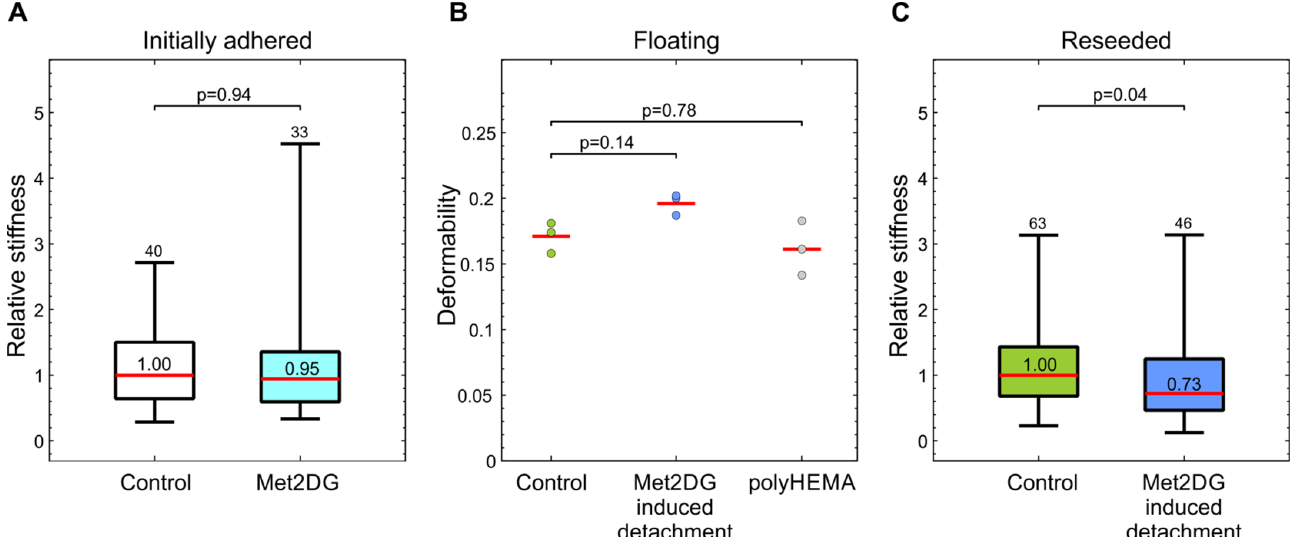
Figure 2. Mechanical properties of met2DG-treated MDA-MB-231 cells. ( A ) Stiffness of initially adhered MDA-MB-231 cells measured by optical tweezers. Met2DG treatment per se does not induce a significant cell softening ( B ) Deformability of floating MDA-MB-231 cells, detached by trypsinization (control), met2DG-treatment or cultured in polyHEMA coated flasks, as measured by deformability cytometry. The met2DG-treated cells are significantly more deformable. ( C ) Stiffness of re-seeded MDA-MB-231 cells measured by optical tweezers. Met2DG-treated cells are significantly softer than control cells. For measurements by optical tweezers, the cell stiffness is given relative to the control. The red horizontal lines represent the medians, boxes span over 50% of the data points, and the whiskers span over the total data range. The median value is indicated in the box, the number of measured cells indicated at the top and the p -values describe the difference relative to the control. For deformability cytometry, the red line represents the mean value of three independent experiments.